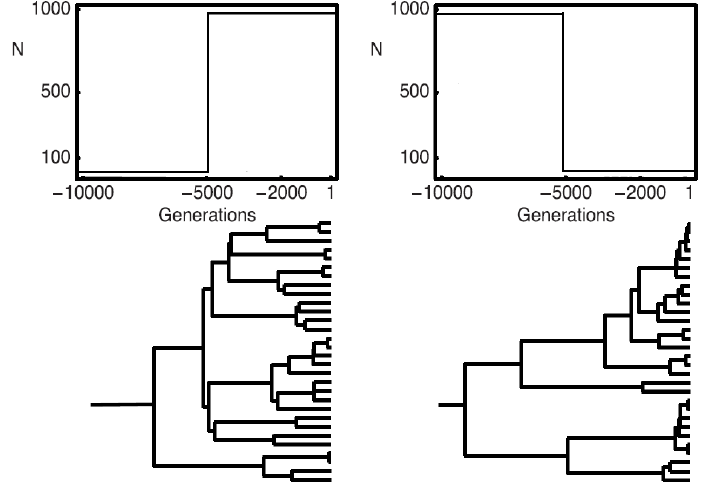
Figure 1. To the left, a population growing from 10 to 1000 individuals; to the right, a population shrinking from 1000 to 10 individuals; on the top, a schematic graph of the population demographies; on the bottom, a realization of a coalescence tree given the